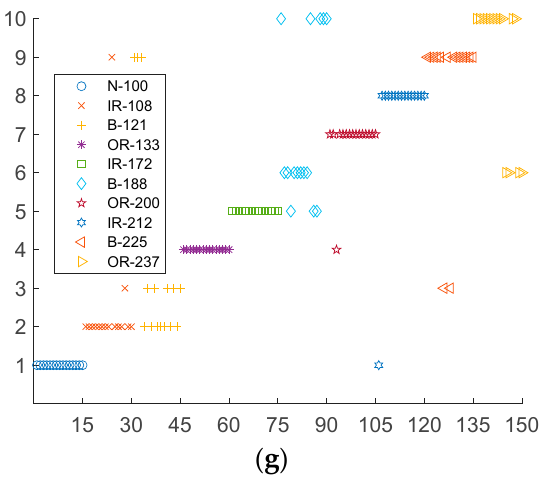
Figure 6. Classification results and distribution of PSO-FrSlEn: ( a ) α = − 0.3; ( b ) α = 0.3; ( c ) α = − 0.2; ( d ) α = 0.2; ( e ) α = − 0.1; ( f ) α = 0.1; ( g ) α = 0.